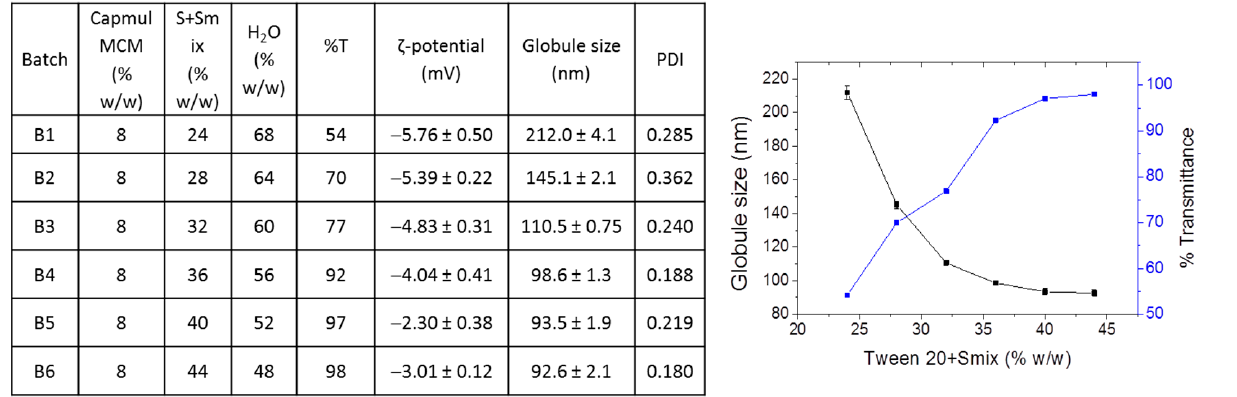
Figure 4. ( a ) Physicochemical properties of NEs composed of Tween 20 or Tween 80 (as the sur- factant). ( b ) Stability of Tween 20 containing NEs (for 8 days at 25 °C). ( c ) Stability of Tween 80-containing NEs (for 8 days at 25 °C).